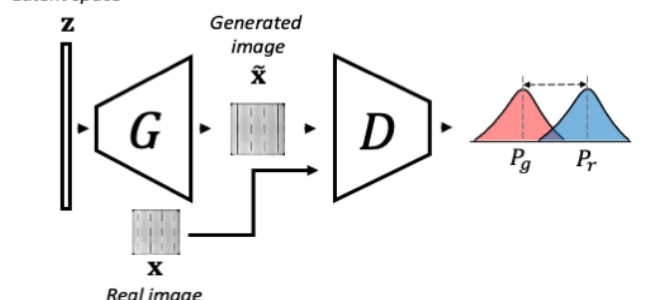
Figure 3. The schema of phase 1 of f-AnoGAN training. The Generator takes a vector z and tries to generate an image that follows the same distribution of the real data. Then, the Discriminator measures the difference between the generated data distribution and the real data distribution. This schema was inspired by the images from Schlegl et al.